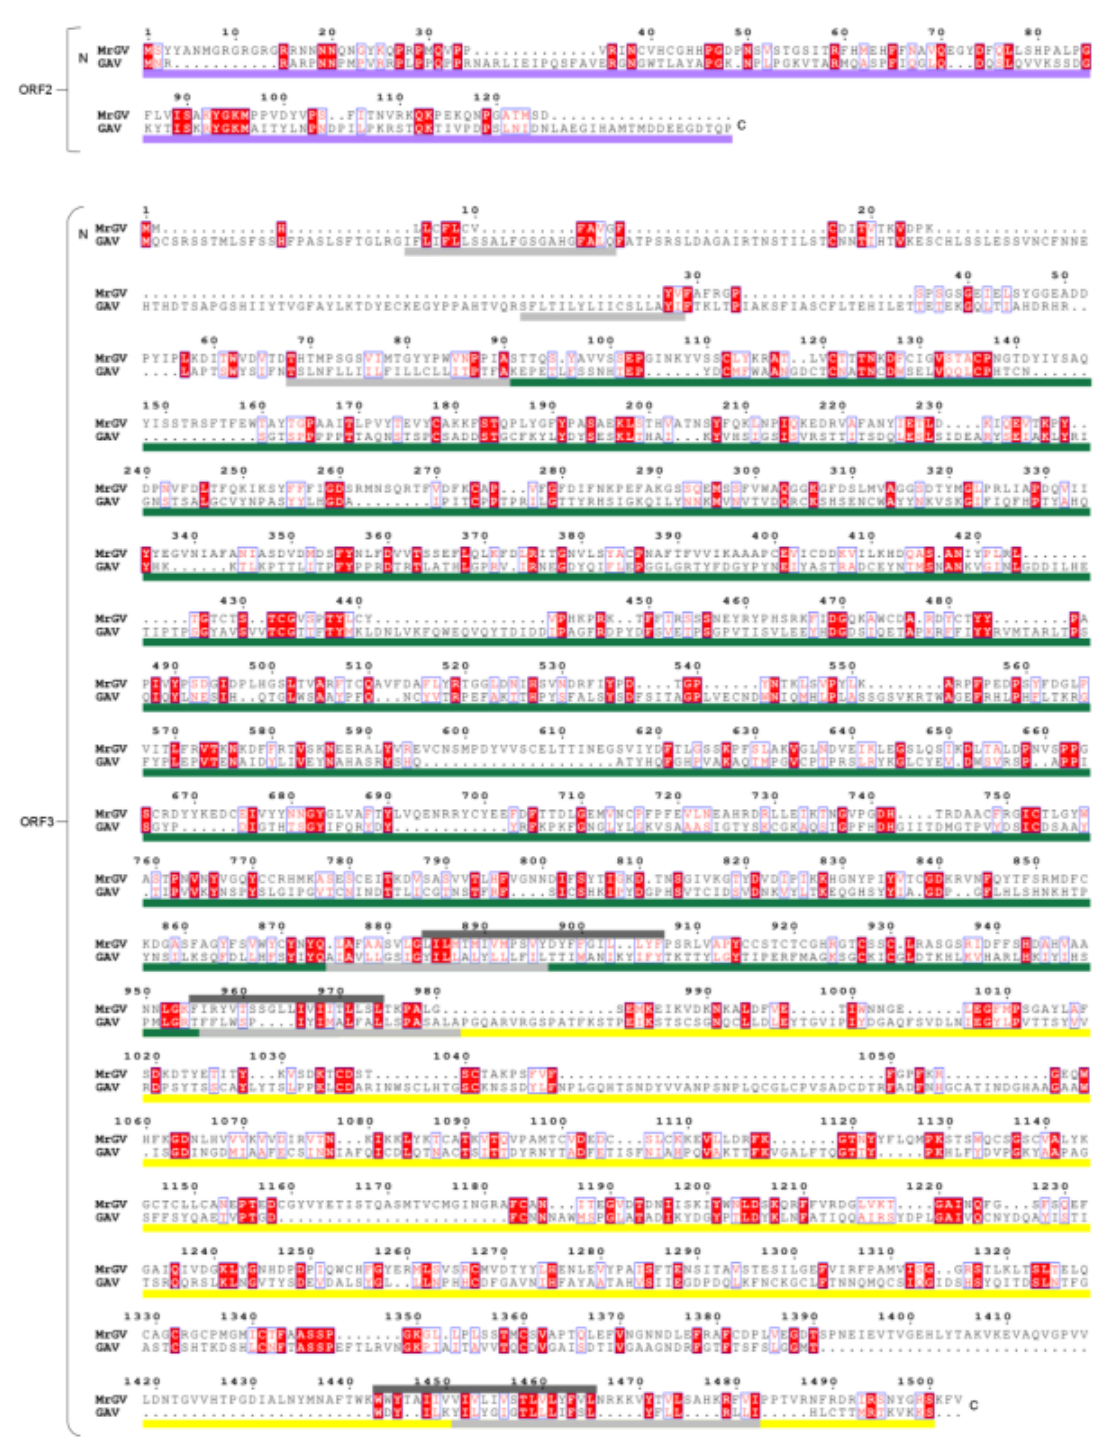
Figure 6. Sequence alignment of MrGV and GAV 3 (cid:48) UTRs. Residue numbering based on the start codon of MrGV ORFs. ORF2 of GAV encodes the p20 nucleoprotein (purple bar). ORF3 of GAV encodes the gp116 glycoprotein (green bar) and gp64 glycoprotein (yellow bar). Transmembrane regions of GAV are shown as light grey bars and TMHMM-predicted transmembrane regions of MrGV are shown are dark grey bars. Residues in red boxes are conserved and residues in blue boxes have > 0.7 Global Similarity Score based on physio-chemical similarities in